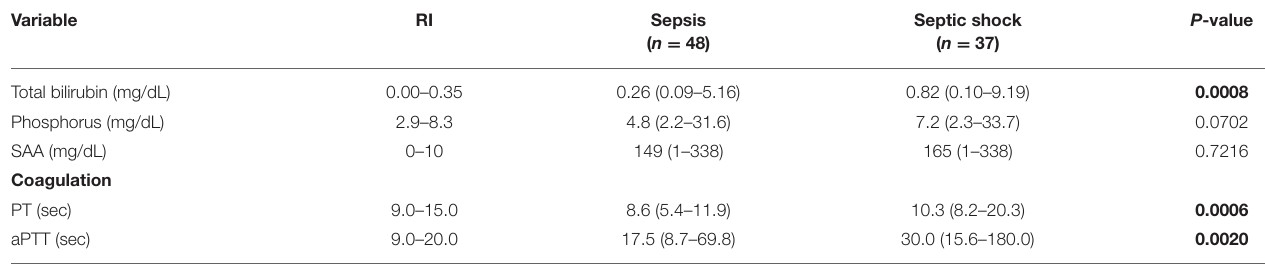
was 3.5 ± 1.8 kg. The BCS was between 1 and 3 in 20/37